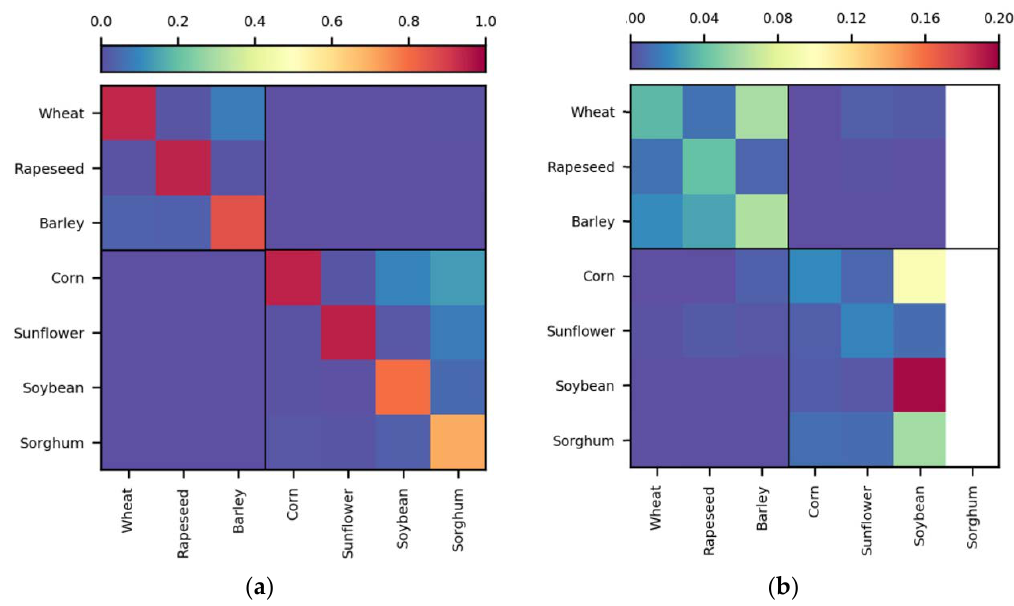
Figure 5. Mean precision ( a ) and associated confidence interval (95%) ( b ) of the classifications per crop for the 10 years. The red tint indicates the best precision values ( a ) and the largest confidence interval or largest error ( b ). The zero confidence values indicate cases where there are not data every year.